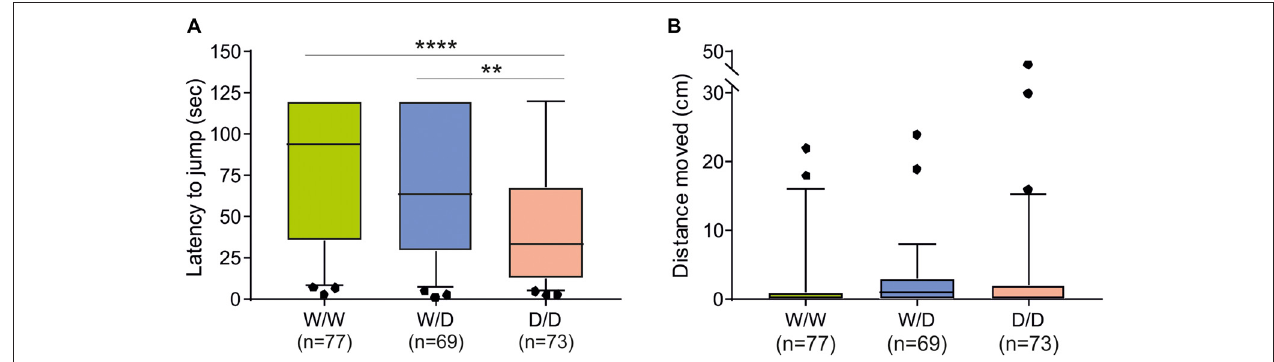
FIGURE 2 | Behavioral performance of newly hatched chicks of three genotypes (W/W, W/D and D/D) in the avoidance test. (A) The latency to jump off differed between chicks of the three genotypes ( P < 0.0001). (B) The distance moved on the balance beam was not significantly different between chicks of the three genotypes. Box plots show medians, first and third quartiles and whiskers with outliers outside the 5th and 95th percentiles. ∗∗ P < 0.01, ∗∗∗∗ P < 0.0001.